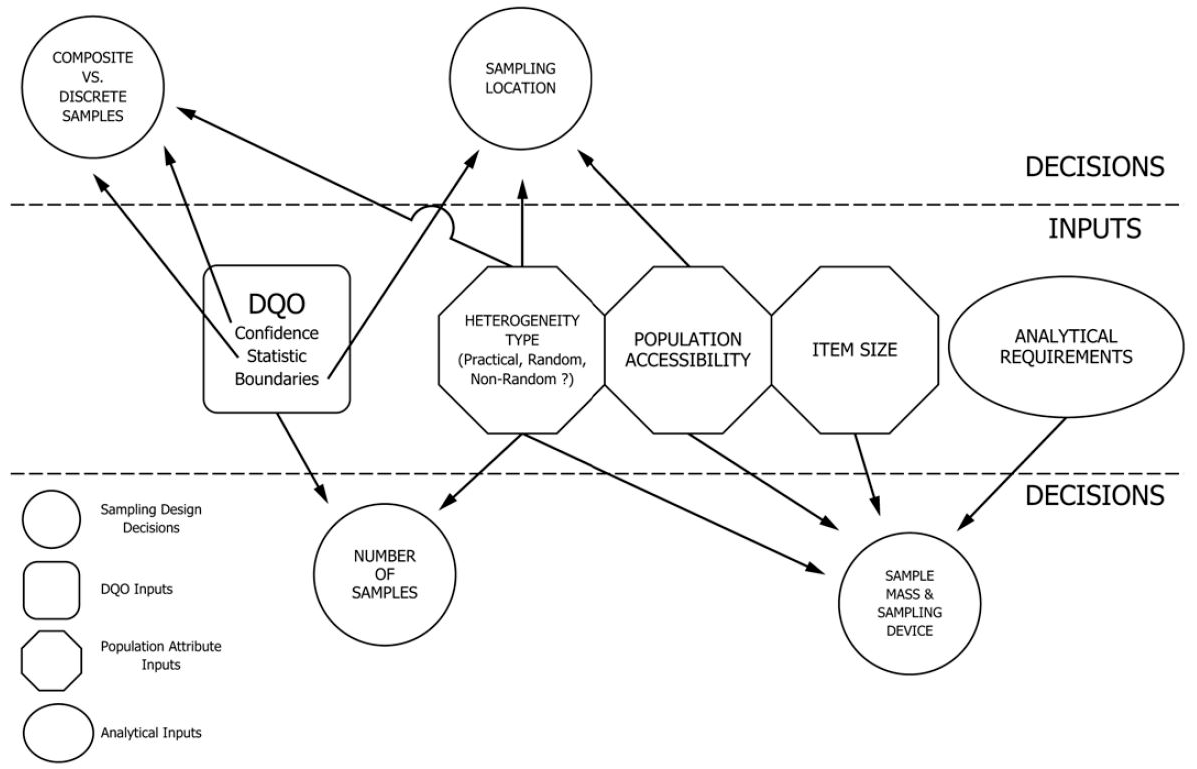
Figure 6. Sampling decisions and sampling design based on data quality objectives (DQO) and population attribute inputs [76].